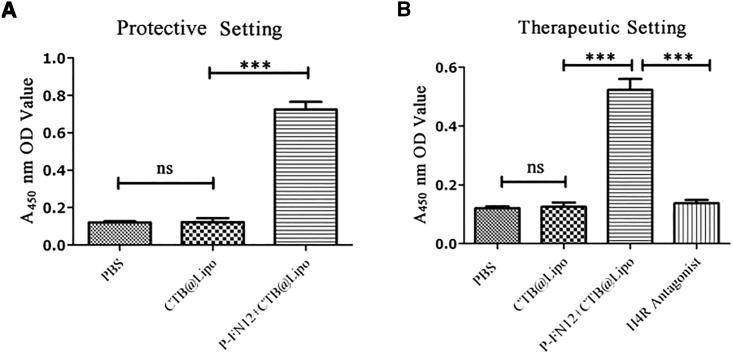
Specificity of Peptide P-FN12 Combined with CTB Formulated with LipoAntibody levels in pooled serum are shown in the protective setting (A) and therapeutic setting (B) (n = 5). ns, not significant; ***p < 0.001. CTB, cholera toxin B.